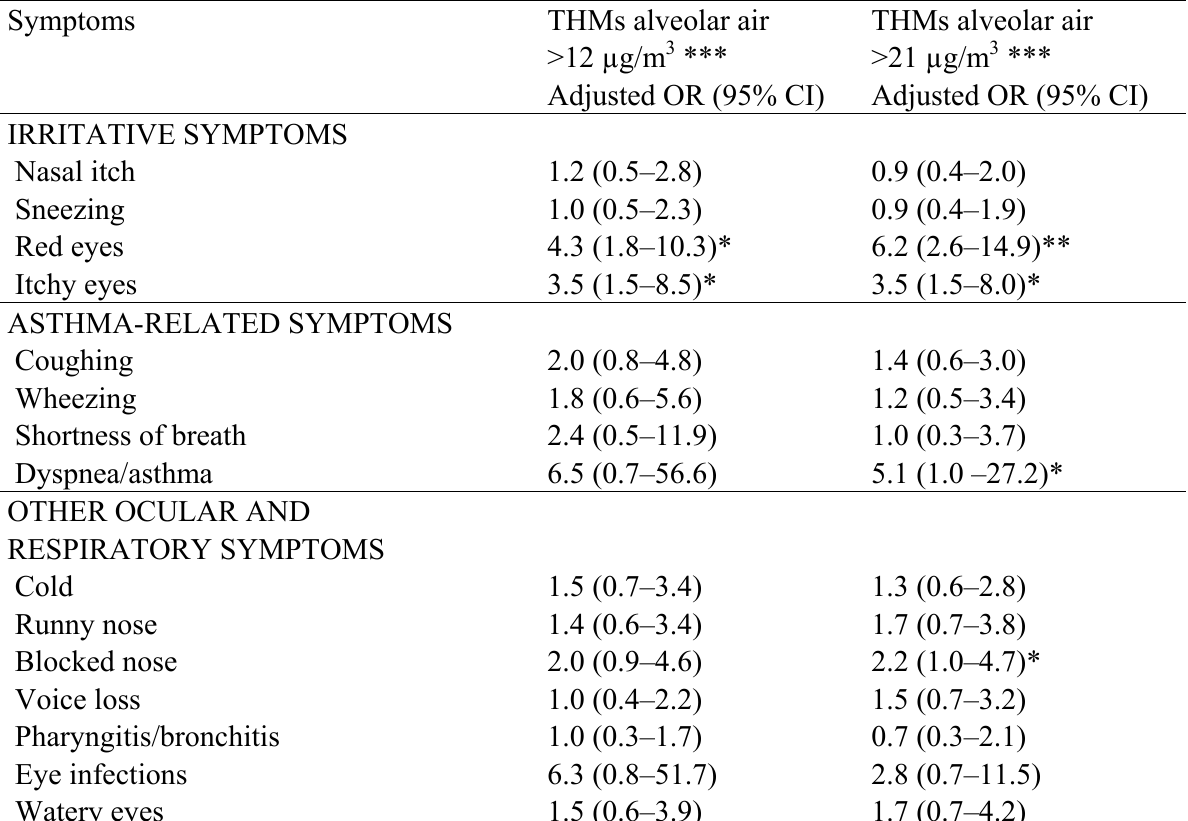
Table 4. Self-reported symptoms and THMs levels from alveolar air samples for 115 occupationally exposed